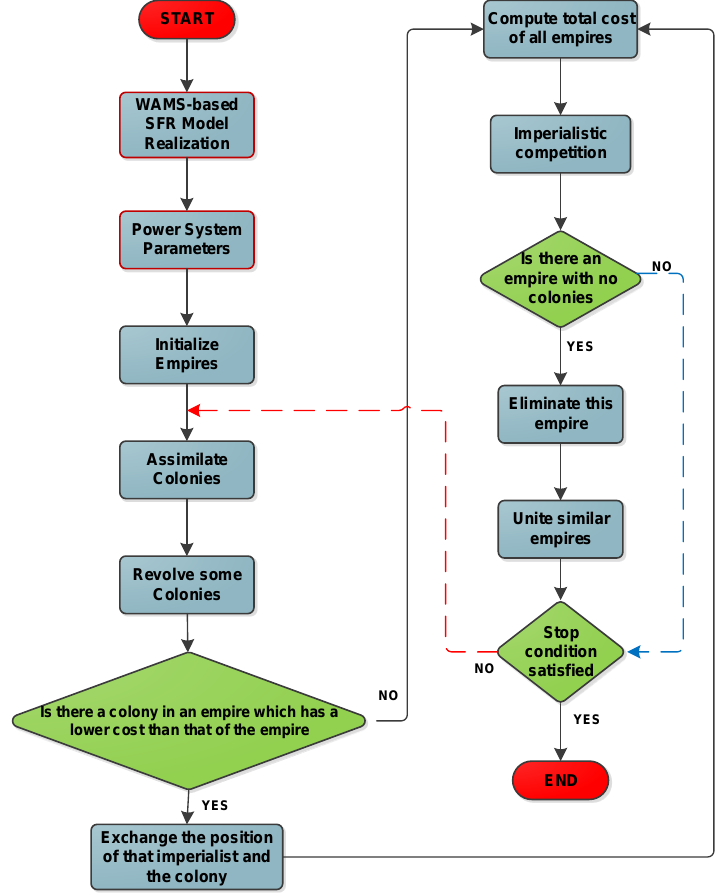
Figure 2. flow chart of the offline implementation of ICA for optimizing the load to be